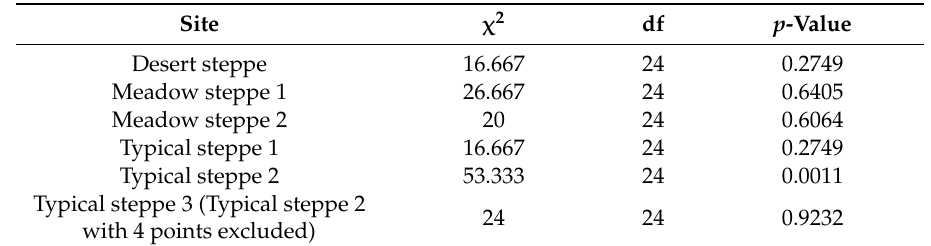
Table 1. Chi-square tests based on quadrat counts for testing complete spatial randomness of site locations; df—degrees of freedom.